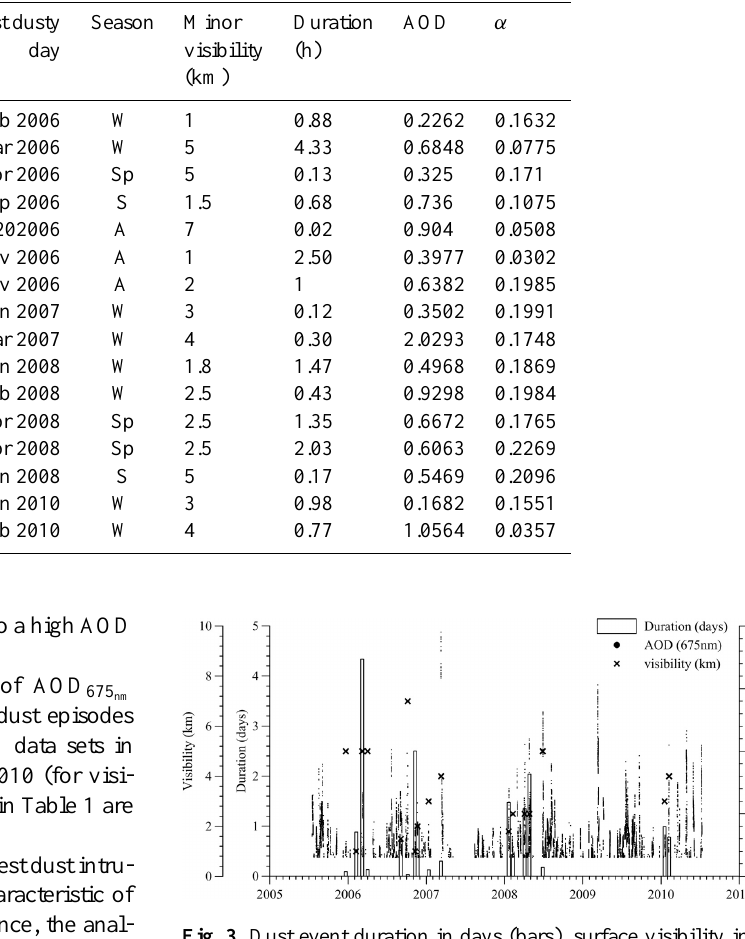
Fig. 3. Dust event duration in days (bars), surface visibility in km (circles) for Canaries, and AOD 657nm > 0 . 15 for Sta. Cruz de Tenerife (dots) for the period